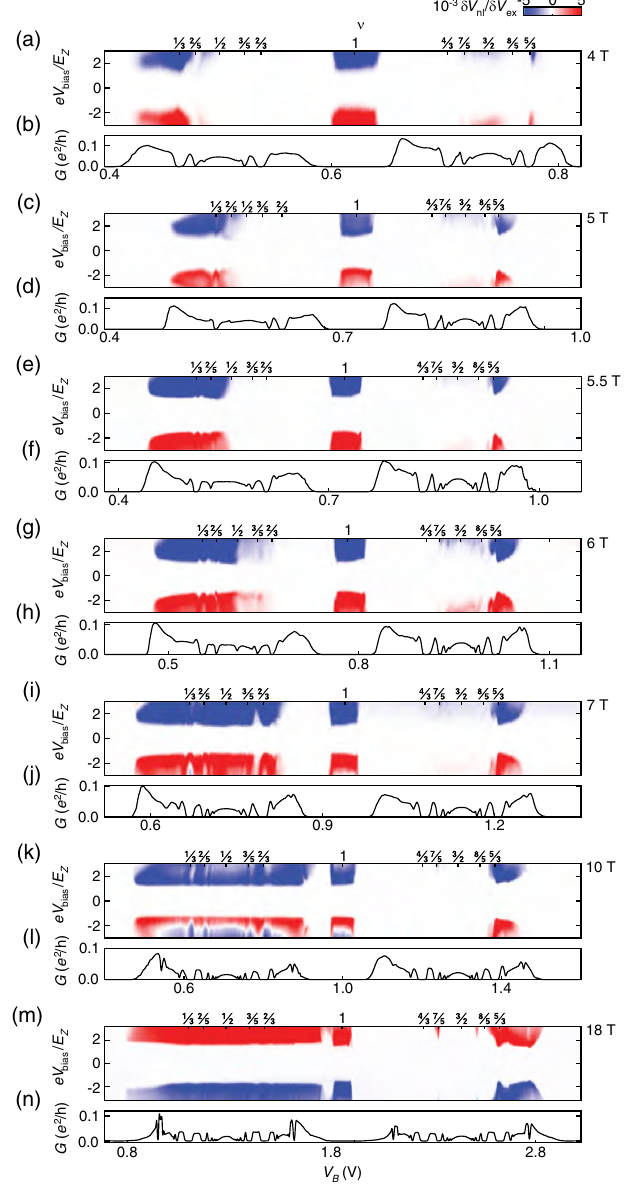
FIG. 6. Magnon transmission at a fractional quantum Hall isospin phase transition. (a) Nonlocal response measured for 0 < ν < 1 as a function of eV =E at B ⊥ ¼ 4 T. (b) Bulk Z I bias conductance as a function of V measured at B ⊥ ¼ 4 T. The B range of V is the same as that in (a). The result is used to B calibrate ν in (a). (c),(e),(g),(i),(k),(m) Same as (a), measured at I B ⊥ ¼ 4 , 5, 5.5, 6, 7, 10, and 18 T, respectively. (d),(f),(h),(j),(l), (n) Same as (b), measured at B ⊥ ¼ 4 , 5, 5.5, 6, 7, 10, and 18 T,